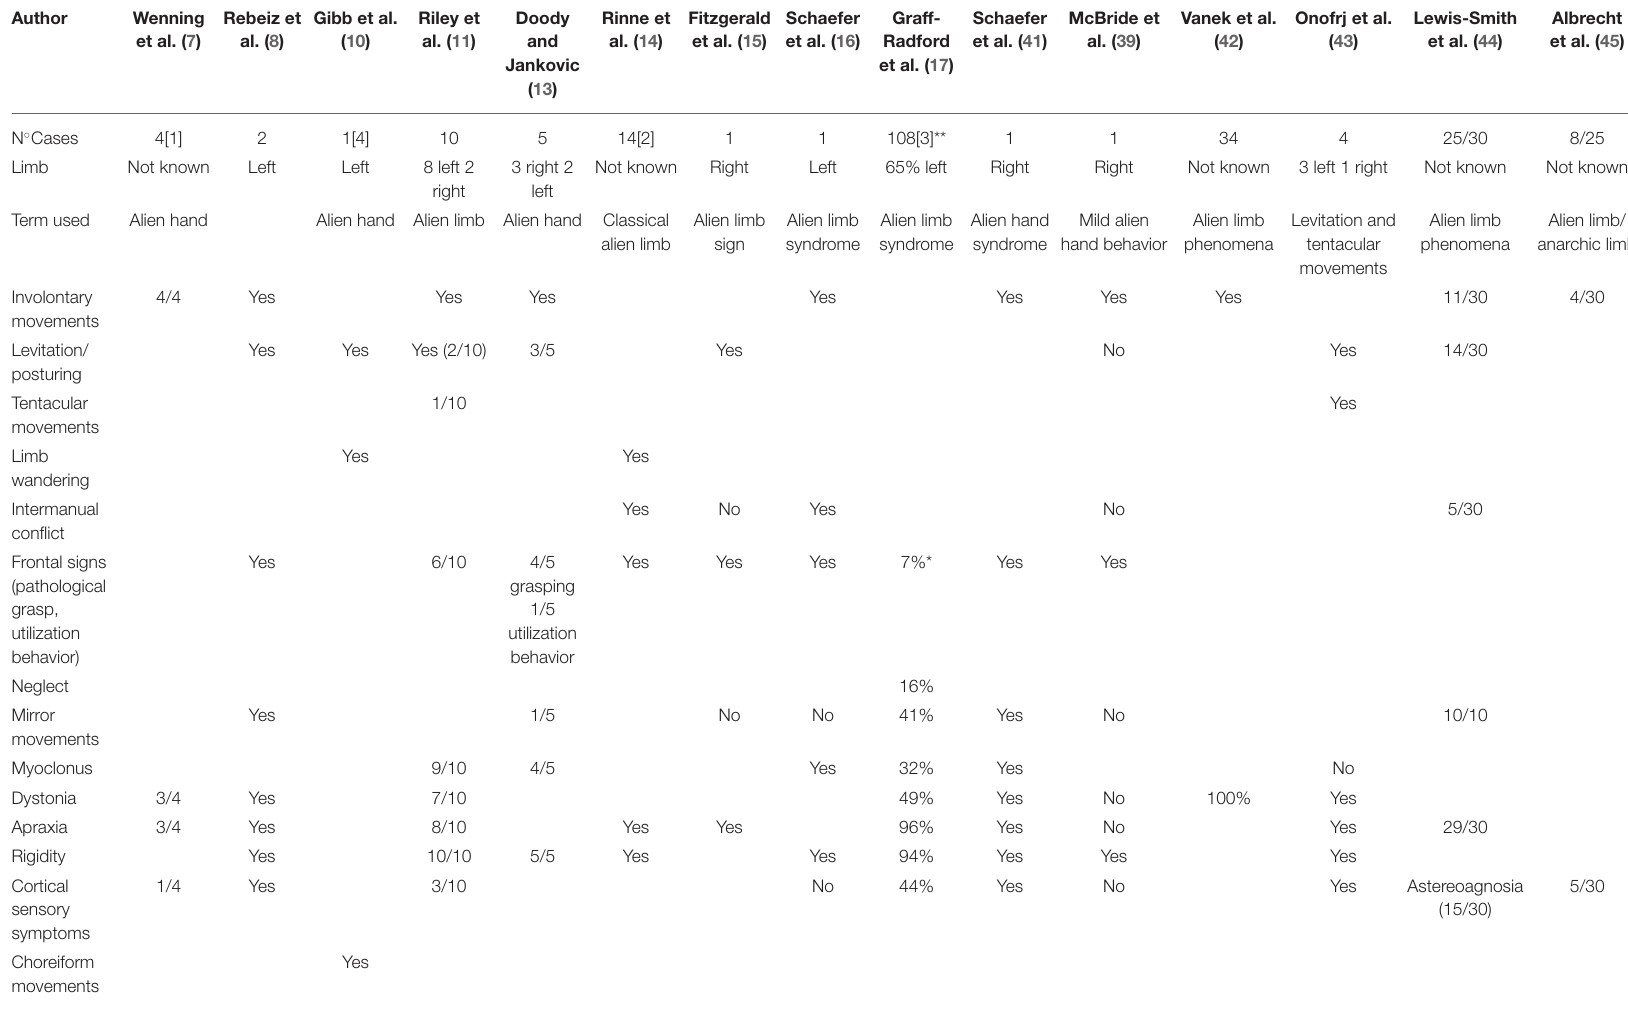
TABLE 1 | Alien hand in corticobasal syndrome: previous case reports and case